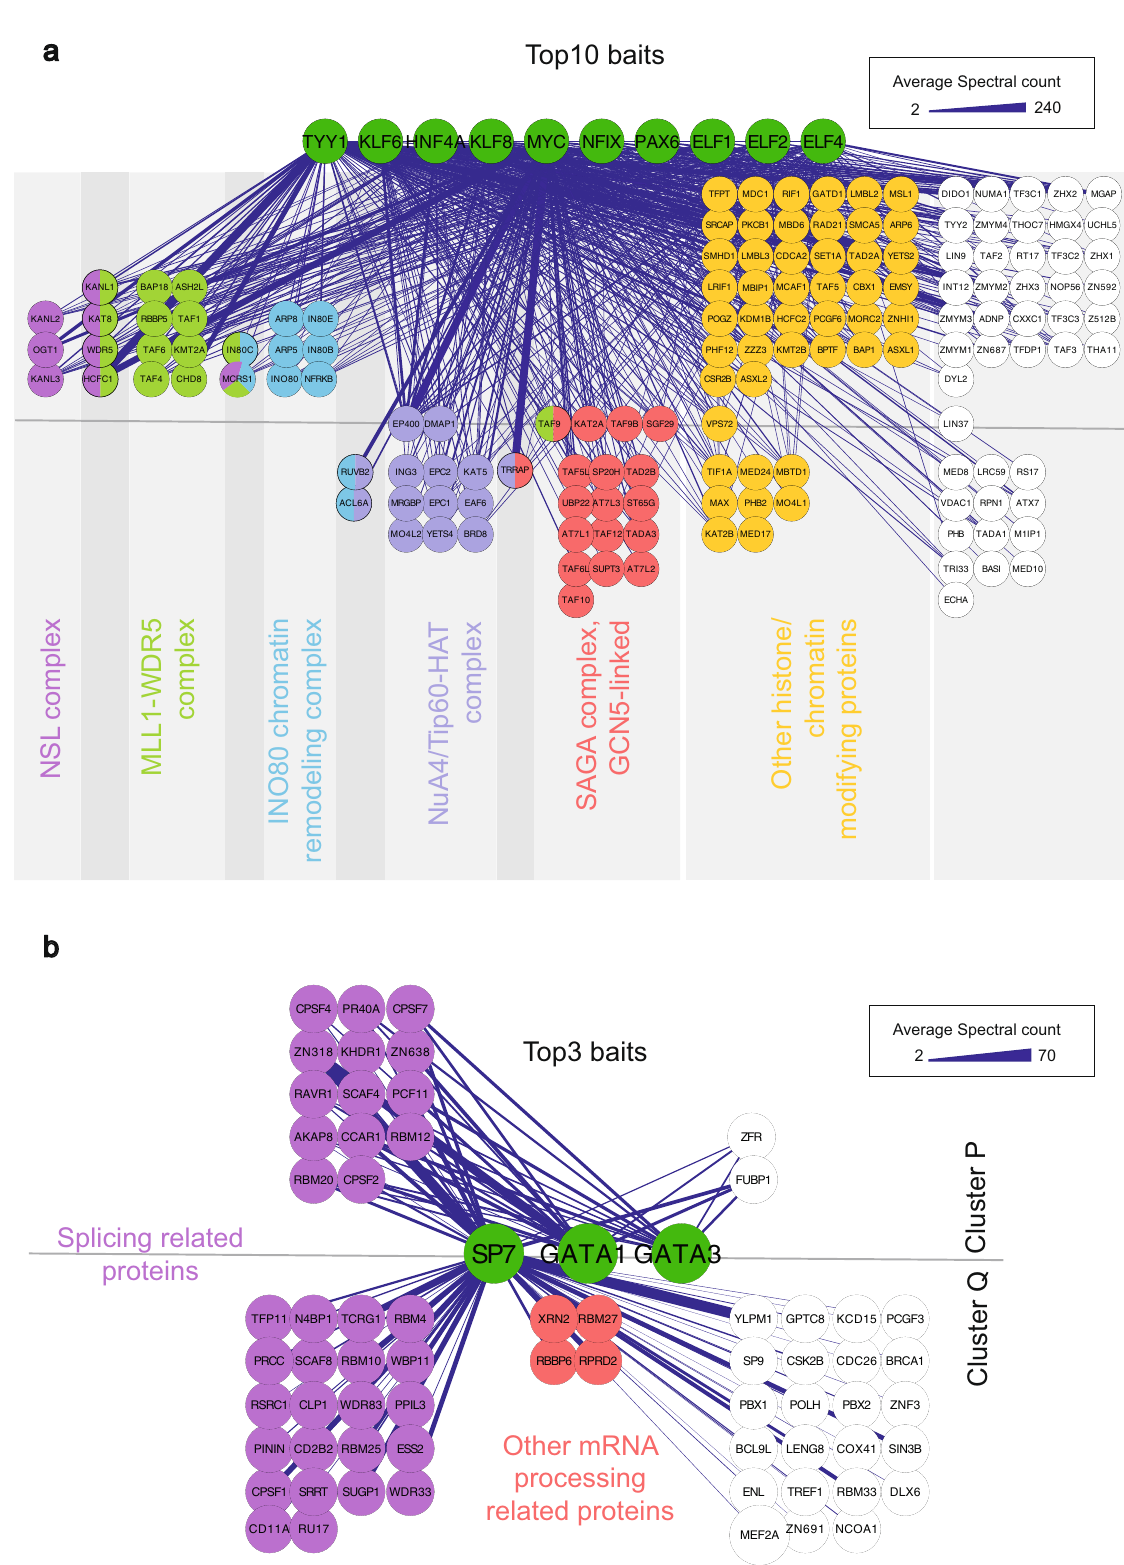
Fig. 6 The interactions in Clusters K, L, P, and Q of the prey-prey correlation analysis from BioID experiment. a The ten baits (TYY1, KLF6, HNF4A, KLF8, MYC, NFIX, PAX6, ELF1, ELF2, and ELF4) with the most interactions in Clusters K and L are shown in the top of the fi gure with green nodes. Most of the preys in Clusters K and L belong to different chromatin-modulating complexes that are highlighted by color coding. b Protein – protein interactions in Clusters P and Q. The three baits (SP7, GATA1, GATA3) with the most interactions in Clusters P and Q are shown in the center of the fi gure with green nodes. Most of the preys in these clusters were linked to mRNA splicing (highlighted in purple). The edge weight displays the average spectral count value detected for the corresponding interaction. Source data of the fi gure are provided as a Source Data fi